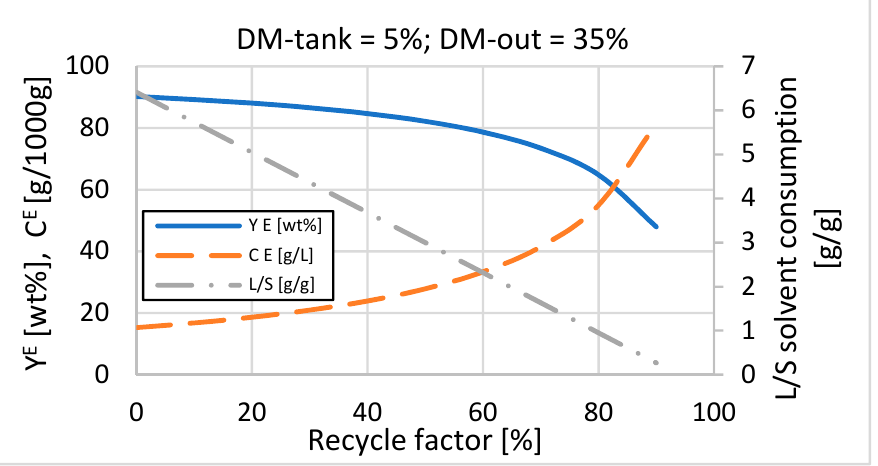
Figure 6. Suspension extraction with recycling for leaching scenario. Extraction yield, extraction concentration, and solvent consumption as a function of the recycling factor. DM-tank = 5 wt % and DM-out = 35 wt %.